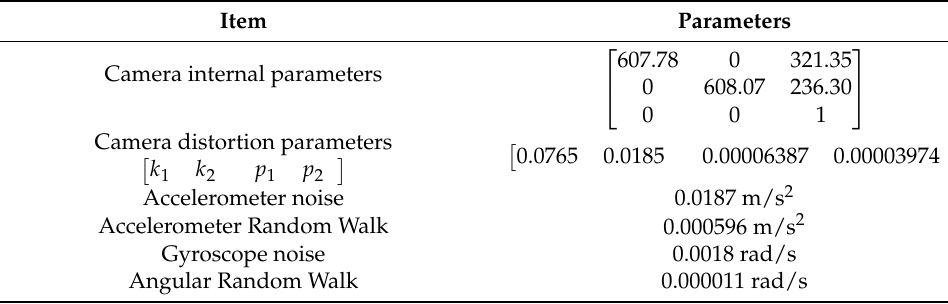
Table 3. Parameters of the camera and